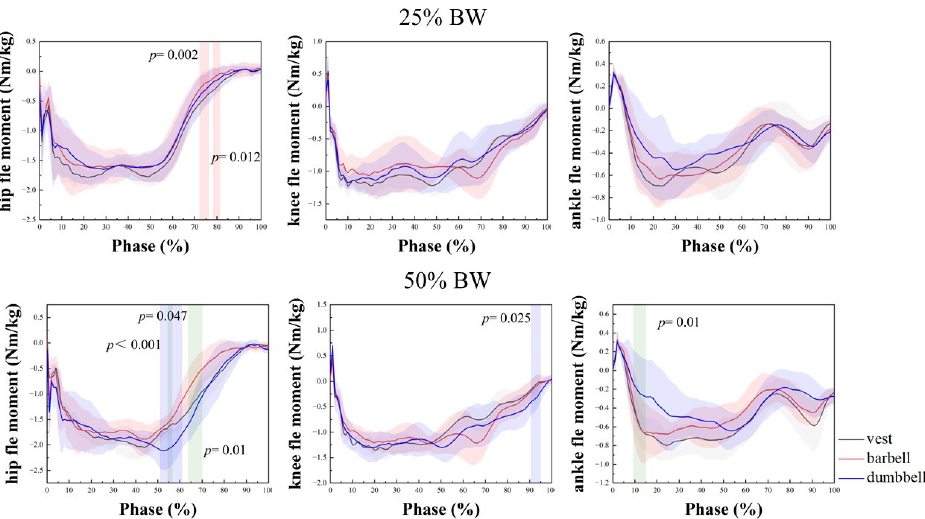
Figure 3. Joint moments and SPM1D results for hip, knee, and ankle at 25% BW and 50% BW. Red: indicates a significant difference between vest and barbell; green: indicates a significant difference between barbell and dumbbell; blue: indicates a significant difference between vest and dumbbell. BW: body weight. Table 2. Peak joint moments of hip, knee, and ankle at 25% BW and 50% BW.